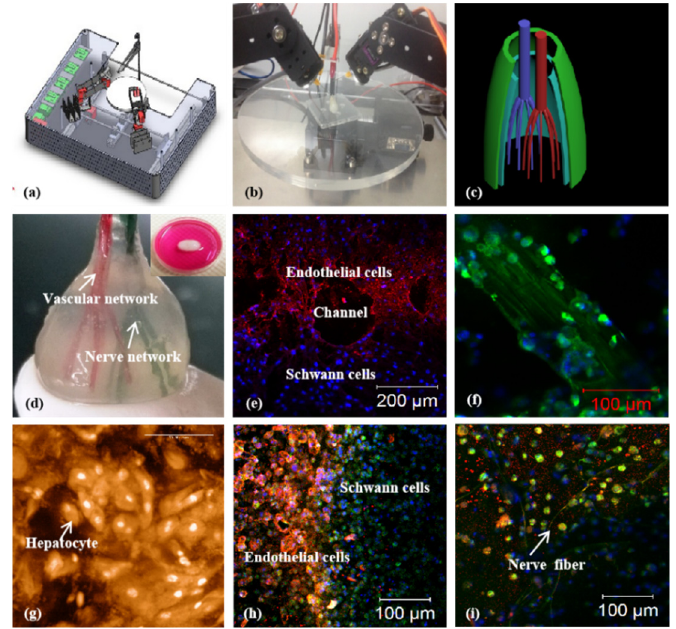
Figure 6. Vascularized and neuralized liver tissue models constructed by Professor Wang: ( a , b ) combined four nozzle printer; ( c ) a CAD model of the vascularized and neuralized liver tissue; ( d ) the 3D printed constructs containing vascularized and neuralized liver tissues; ( e ) immunofluorescence staining of endothelial cells and Schwann cells around the branching channels of the constructs; ( f ) nerve fibers formed in the 3D constructs; ( g ) hepatocytes in the 3D constructs, some of the cells in proliferation stage with two nucleus; ( h ) the interface between the endothelial cells and Schwann cells ; ( i ) nerve fibers formed in the constructs. Reprinted from Ref. [75].